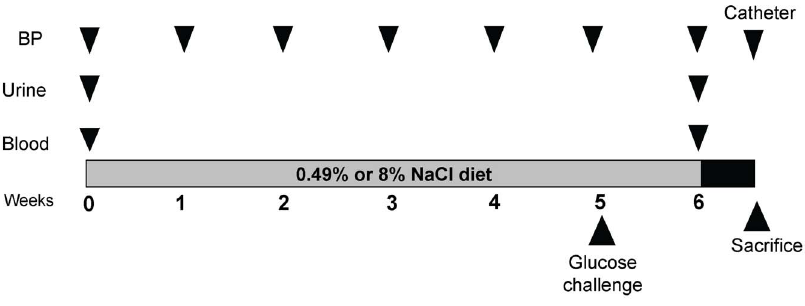
Figure 1. Schematic showing the time frame and experimental protocol followed to induce hypertension by high-salt feeding. Measurements period of BP, glucose challenge, urinary collection and blood draw are also shown. BP=blood pressure.